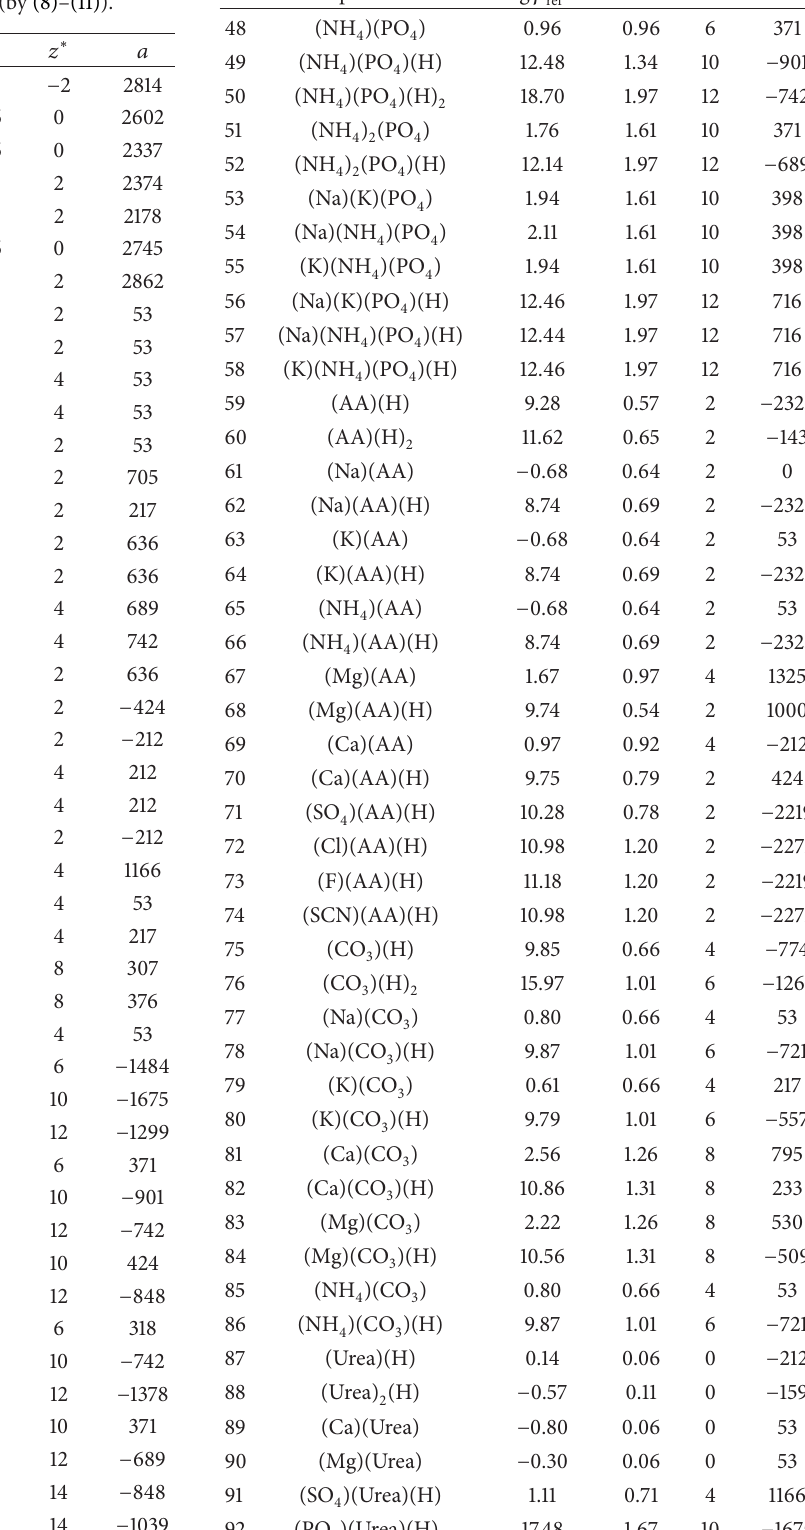
Table 3: Stability constants of SALMO species at 𝑡 = 37 ∘ C and 𝐼 = 0.15 molL −1 ionic strength and corresponding parameters for their dependence on ionic strength and temperature (by